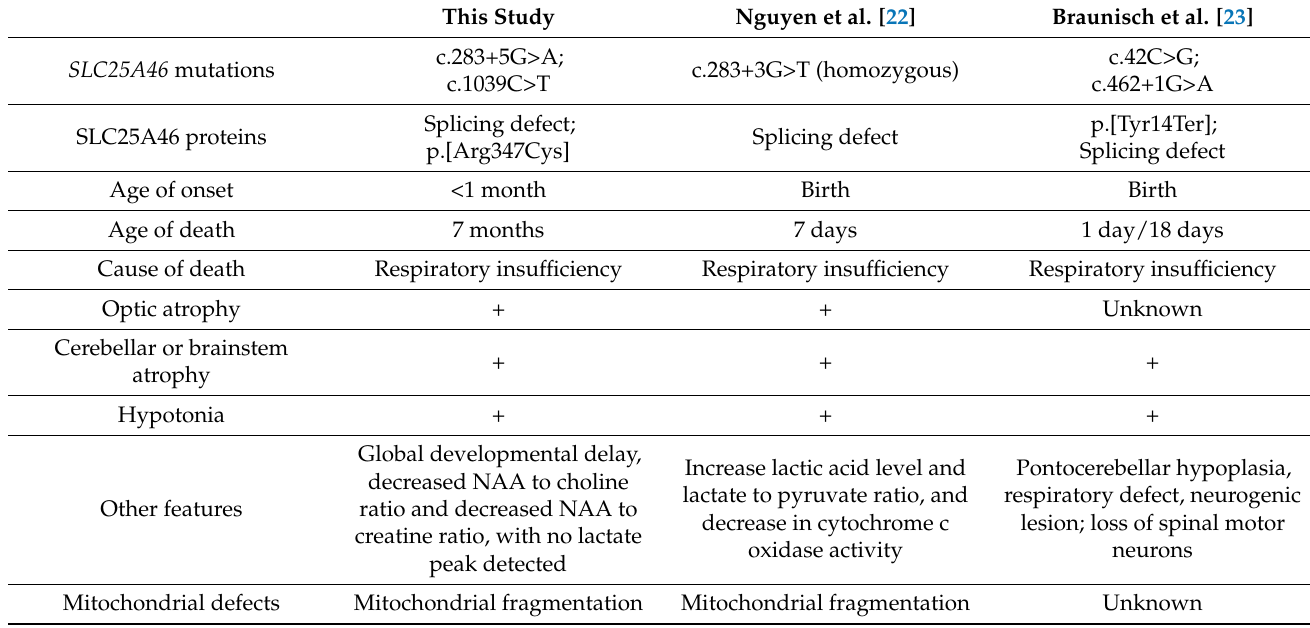
Table 1. Genetic and clinical findings in individuals with SLC25A46 splicing variants. NAA: N-acetyl